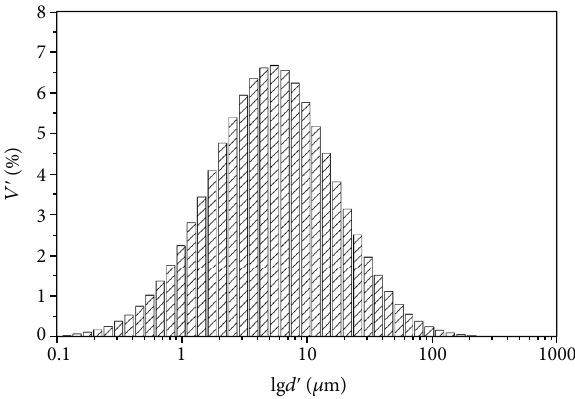
Figure 4: Particle diameter d and volume frequency V curve.